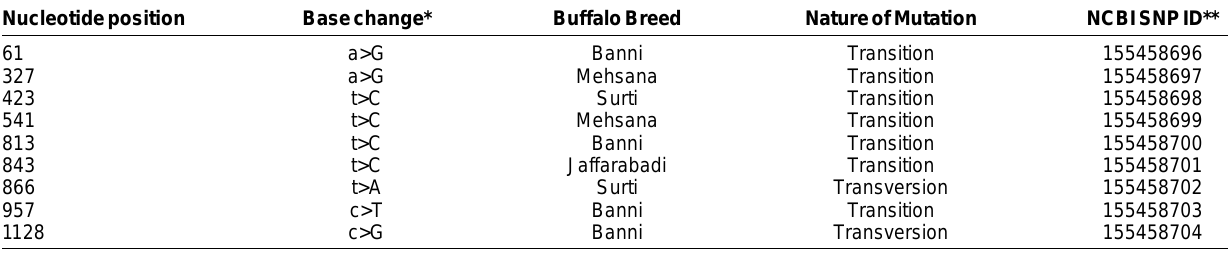
Table-1. SNPs in OLR1 Intron I of Jaffarabadi, Surti, Mehsani and Banni buffalo Nucleotide position